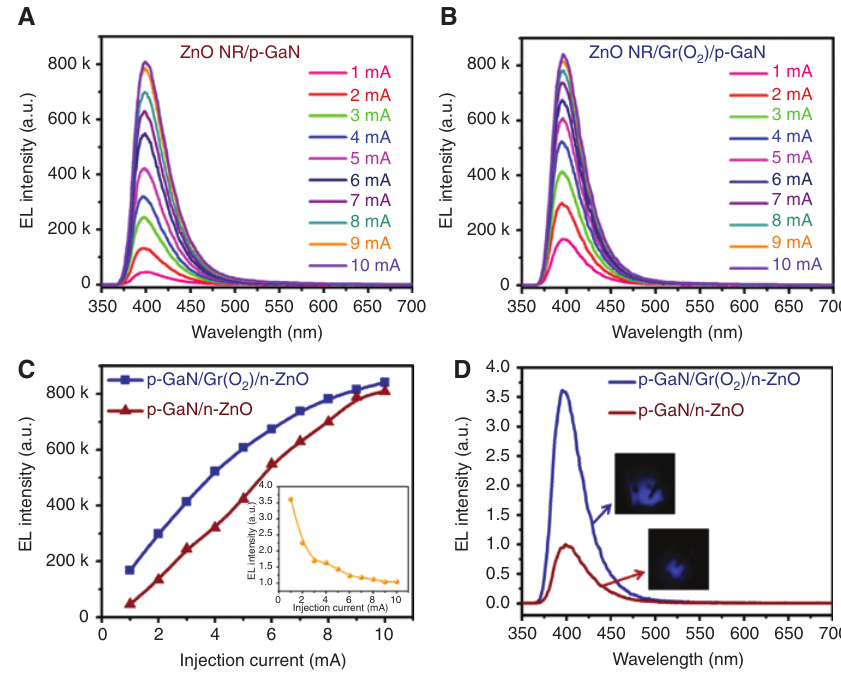
Figure 5: EL spectra of both LEDs (A) without and (B) with graphene plasmon layer decoration, collected at the front of the devices for variable injection currents from 1 to 10 mA. (C) Relationship among integral intensity, improvement ratio, and injection current. (D) EL measurement of light-emitting devices without and with a graphene plasmon layer collected at an applied current of 1 mA. The insets show instant EL